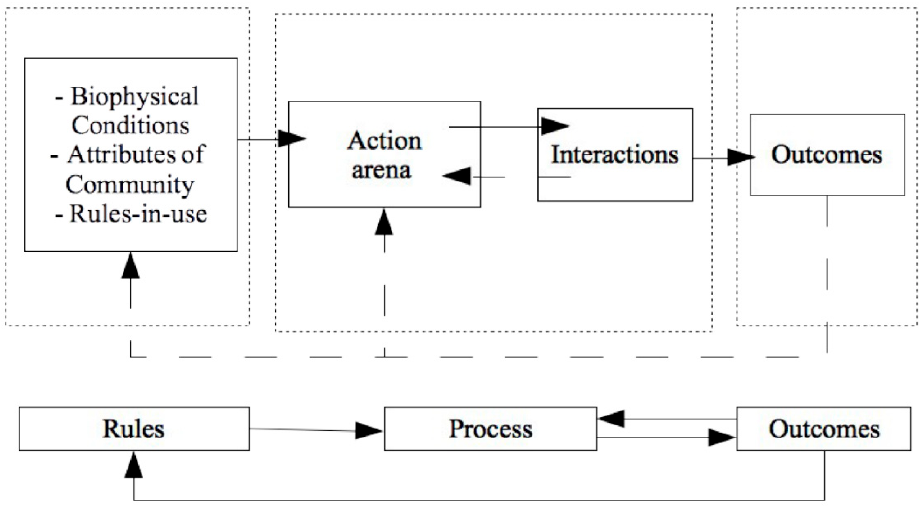
Figure 2. Approaching the IAD framework by three-dimensional model rule-process-outcomes.